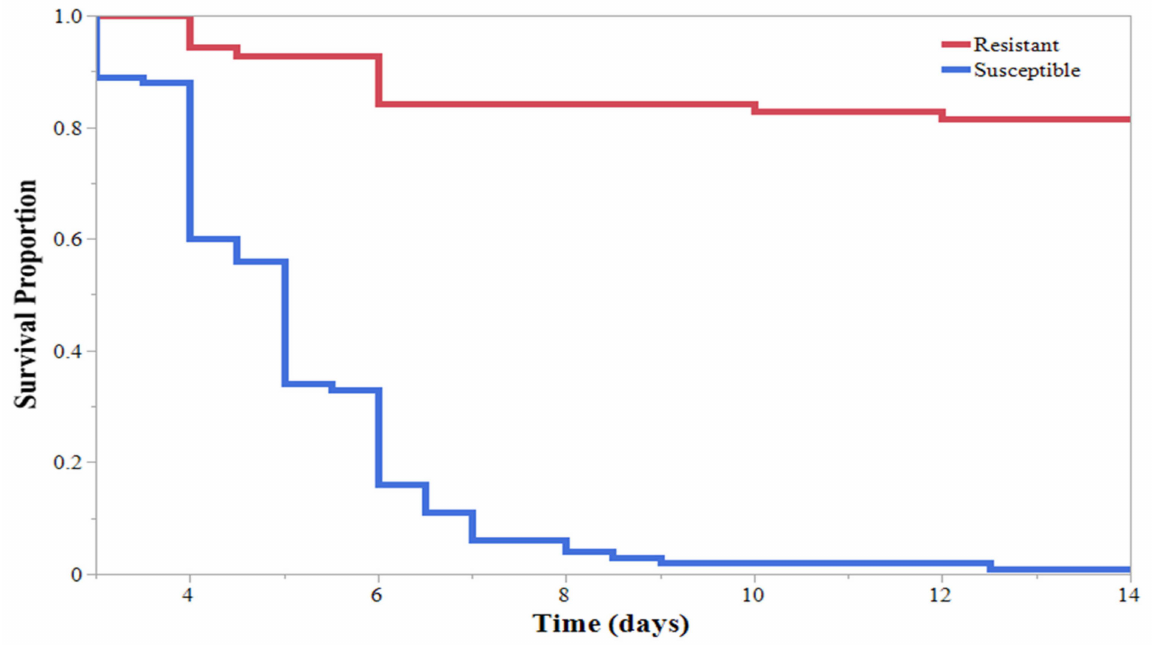
Figure 3. Kaplan–Meier survival curves for Helicoverpa zea (Lepidoptera: Noctuidae) larvae grouped into “Resistant” (4th and 5th instars) and “Susceptible” (1st, 2nd, and 3rd instars), reared on V3 soybeans sprayed with Helicoverpa armigera nucleopolyhedrovirus. Significant differences were observed between survival curves. Log-rank test: χ 2 = 123.89, p <